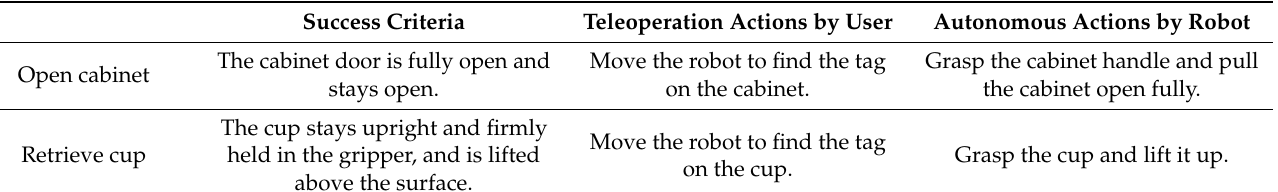
Table 1. How a user and a robot work together under VGS control for a multi-step drinking